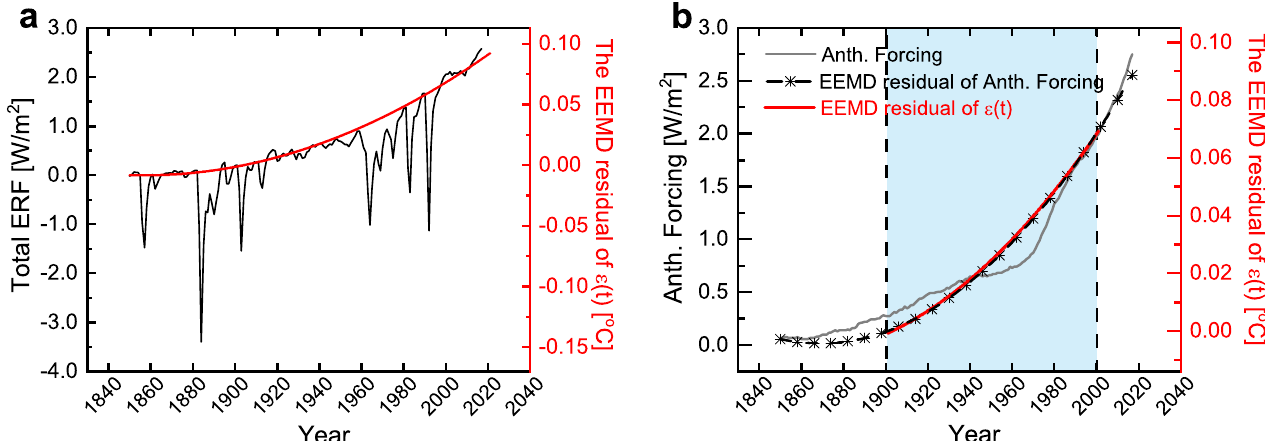
Fig. 2 Comparison of the direct-forcing-response trend extracted from the GMTA and the historical effective radiative forcing (ERF) estimates. The ERF estimates are from the IPCC AR5 47 , and they are further extended to 2017 by Dessler and Foster 47,48 . a a rough comparison of the direct-forcing-response trend with the historical ERF. Using the EEMD method, the trend of the direct-forcing-response is detected as the residual component of the EEMD analysis (see also Fig. 1e) and shown here as the red curve. The two variables have different units, but from this rough comparison, a close relationship between the trend of the ε ( t ) and the trend of the ERF can be observed. b a detailed comparison of the trend of the ε ( t ) (the red curve) with the trend of the historical anthropogenic ERF data (the black asterisk-dashed curve). Again, the EEMD method is used to detect the trend of the historical anthropogenic ERF data. In view of the poor data coverage for the calculation of GMTA in the 19th century and the boundary effects of the EEMD analysis, the comparison is made over the time of the 20th century (the blue box). A close relationship between the two trends can be